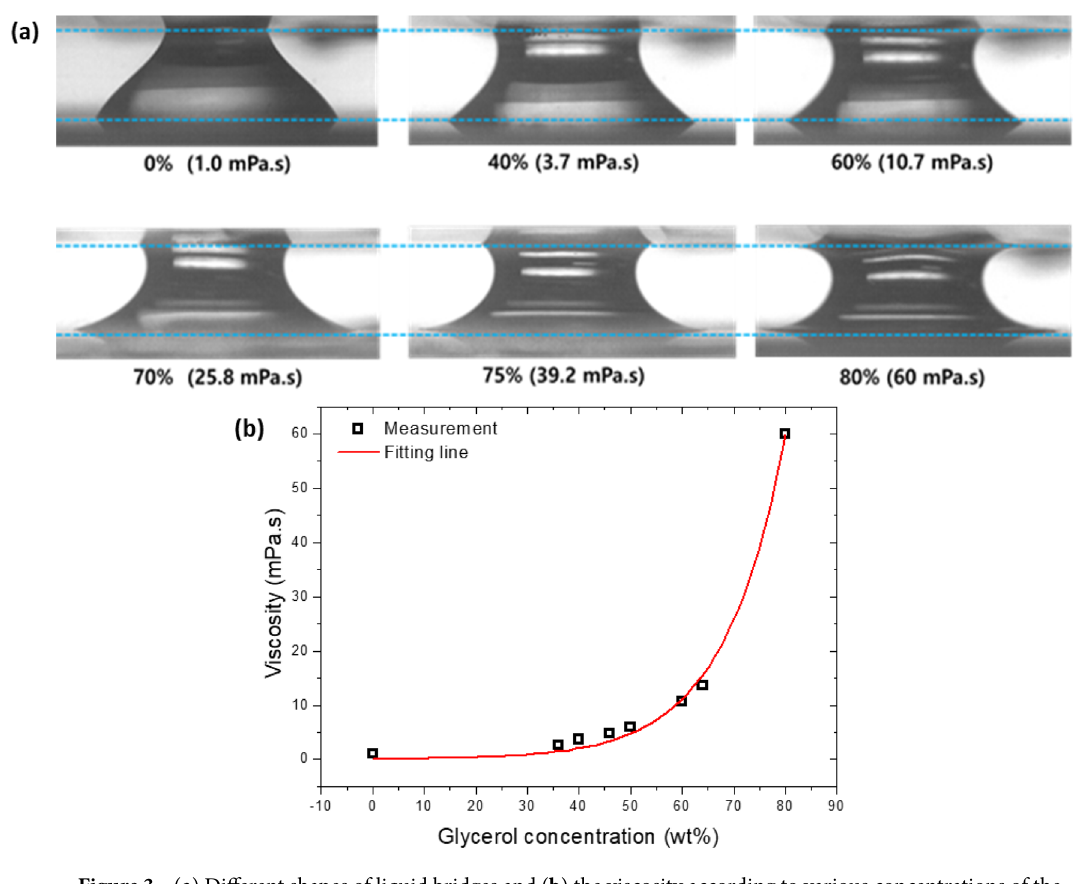
Figure 3. ( a ) Different shapes of liquid bridges and ( b ) the viscosity according to various concentrations of the glycerol mixture.